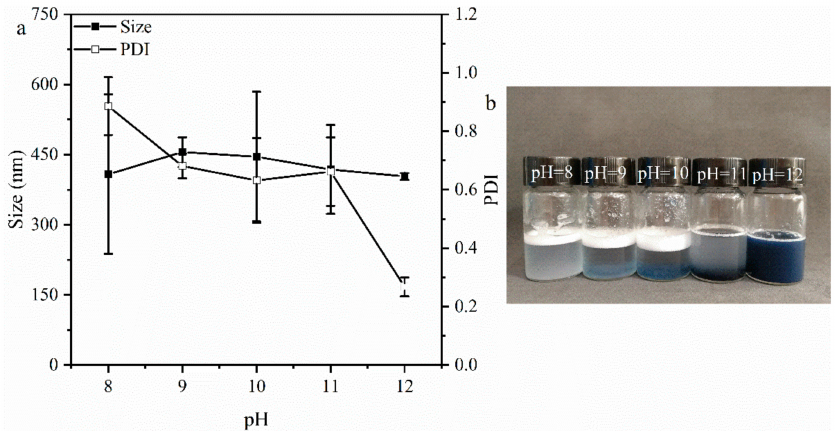
Figure 1. ( a ) Particles size of gelatin nanoparticles (GNPs) prepared at di ff erent pH values (pH 8–12). ( b ) Photograph of GNPs dispersions after 1 h of storage (the white layer is the foam layer).